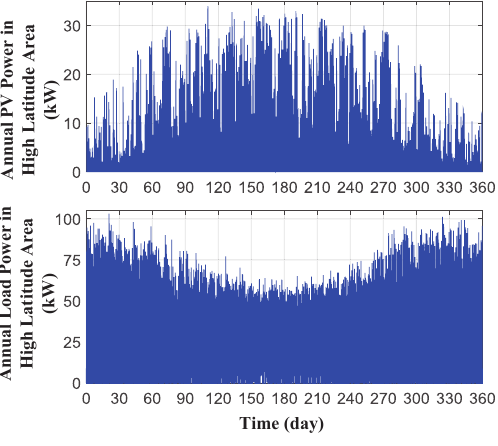
Figure 15. Annual PV and load power data of a residential building in a high altitude